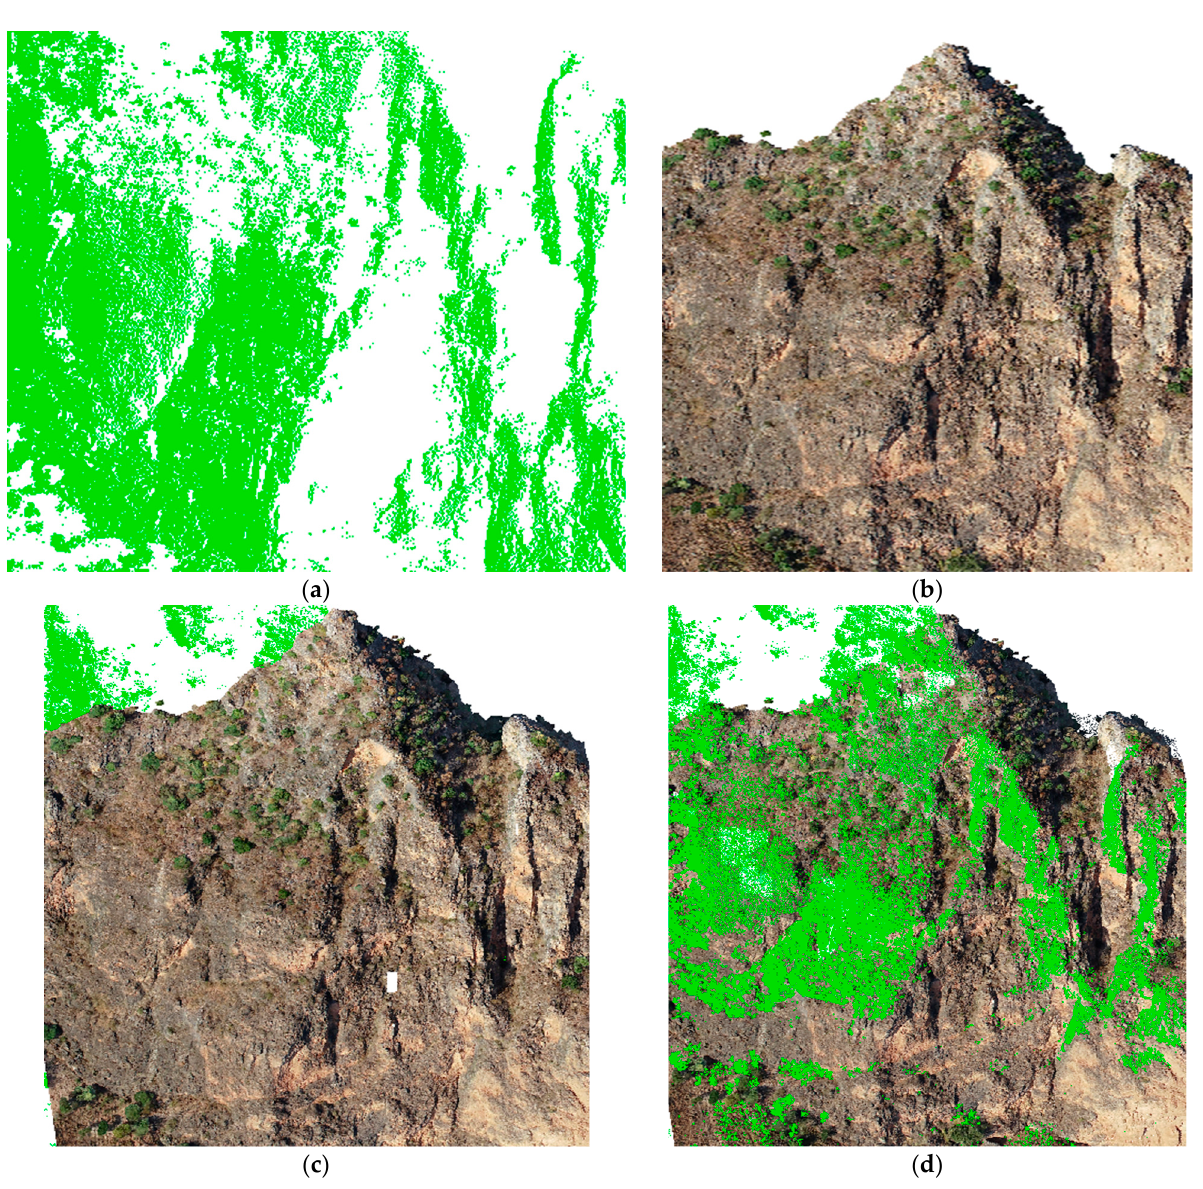
Figure 9. Multi-source point cloud fusion diagram: ( a ) position-specific TLS point cloud; ( b ) position-specific UAV point cloud; ( c ) uniform coordinate system method for roughly fusing point clouds; ( d ) improved ICP algorithm to fuse point clouds.